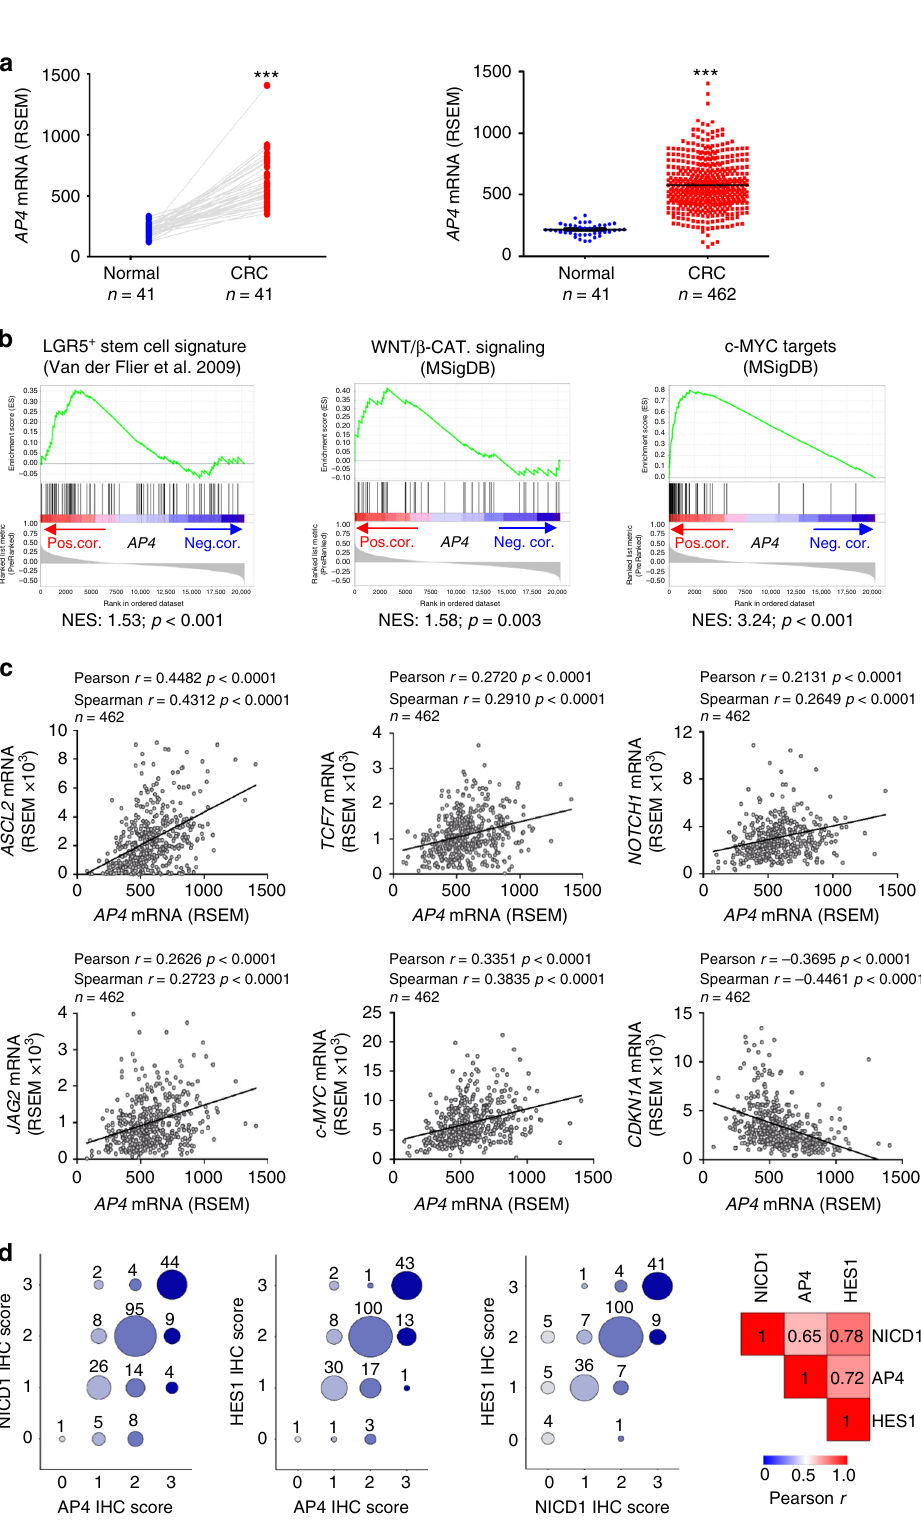
reaction with a RNA-T7 Polymerase by using the DIG Northern Starter Kit (Roche Diagnostics). During the transcription reaction, the probe was labeled with digoxigenin (DIG). The in situ hybridization was performed on freshly prepared 8 µm paraf fi n sections as described 52 . Isolation of IECs . Each part of the intestine was dissected longitudinally and cut into small pieces. IECs were isolated by shaking the tissue in Hanks' Balanced Salt solution/ethylene-diamine-tetra-acetic acid (HBSS/EDTA) at 37°C for 10 min.